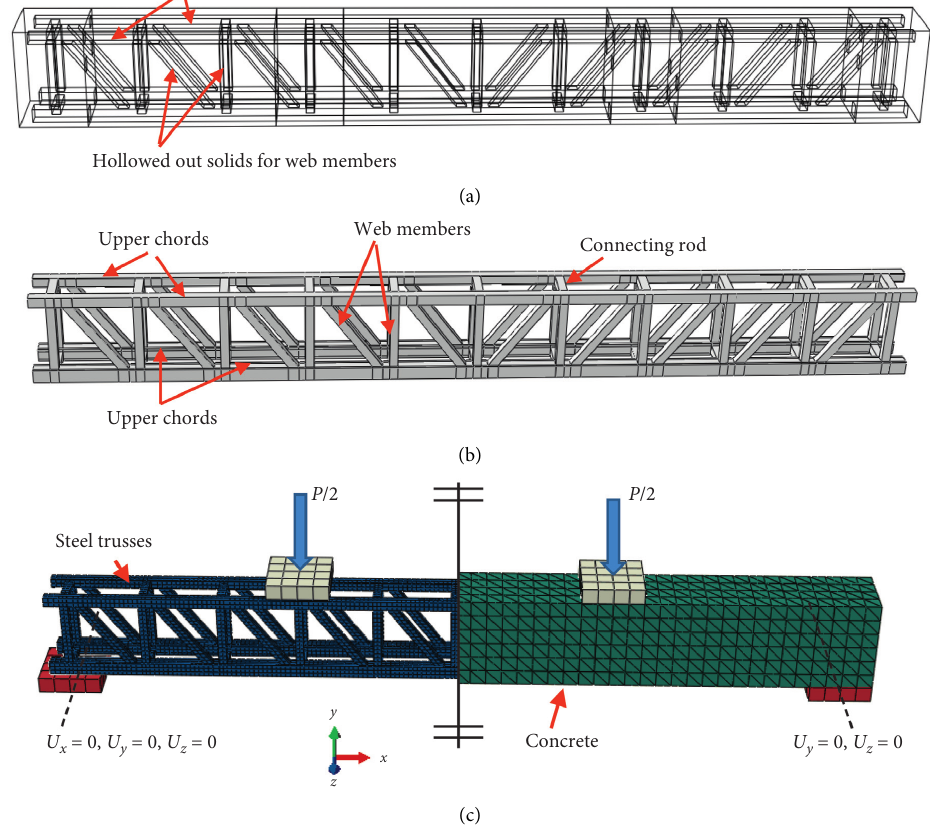
Figure 2: Finite element analysis model. (a) Part of concrete beam. (b) Part of steel tube truss. (c) Loading and